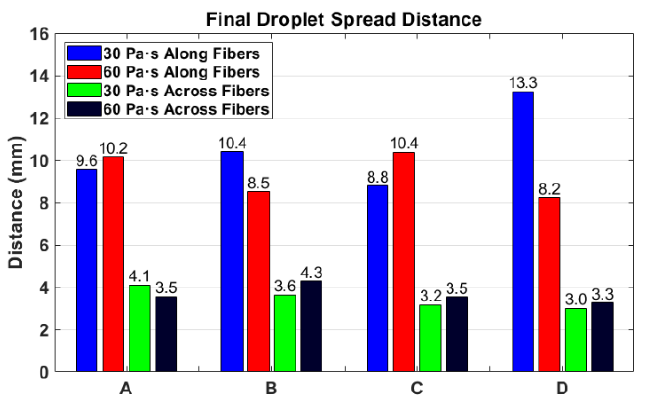
Figure 9. Relationship between fiber bed type and spread, in directions across and along the fibers.